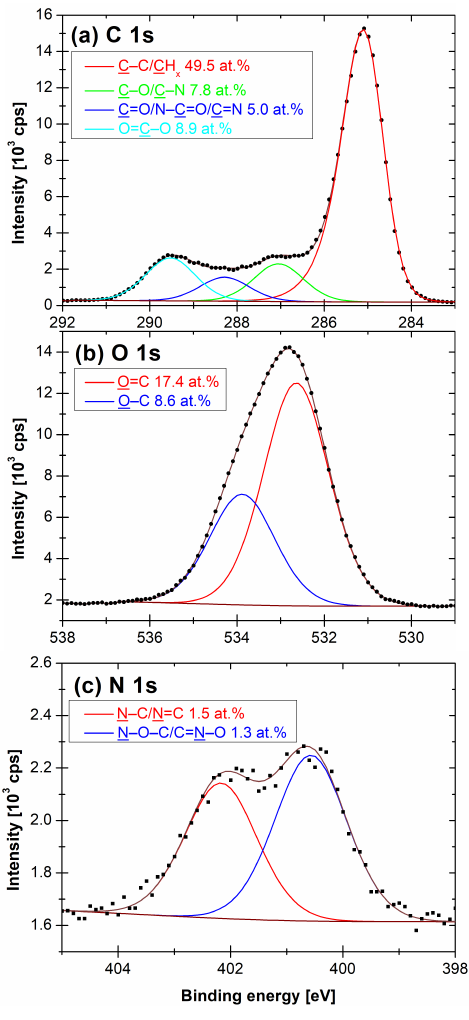
Figure 2. A fitting of ( a ) C1s, ( b ) O1s and ( c ) N1s high-resolution XPS spectra of the Ar- s